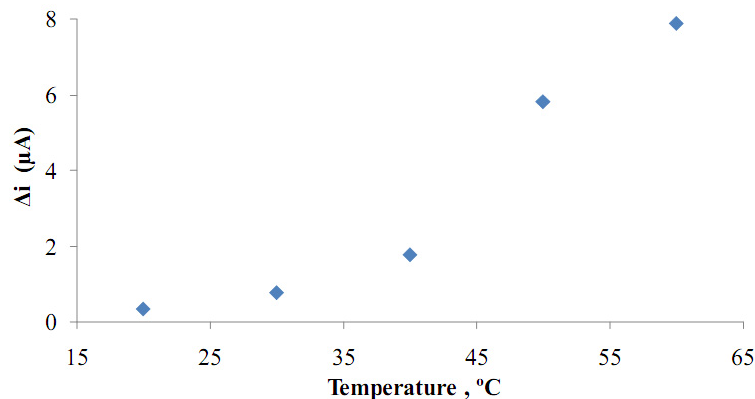
Figure 7. The effect of temperature on the response of the biosensor (at pH 7.5, 1.0 × 10 − 5 M glucose at 0.4 V operating